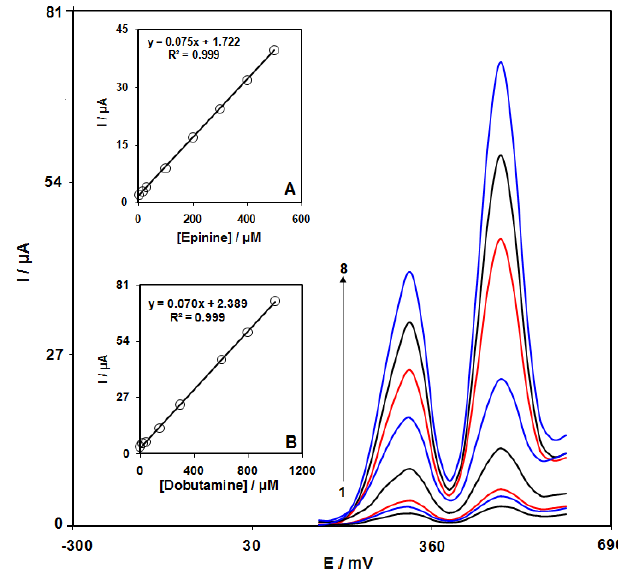
Figure 12. DPV graphs at the GO/ZIF-67/SPE in 0.1 M PBS at pH of 7.0 with various concentrations of epinine and dobutamine. Notably, numbers 1–8 correspond to 2.5 + 5.0, 15.0 + 25.0, 30.0 + 50.0, 100.0 + 150.0, 200.0 + 300.0, 300.0 + 600.0, 400.0 + 800.0, and 500.0 + 1000.0 μ M of epinine and dobutamine. ( A ): Ip plot vs. epinine concentration. ( B ). Ip plot vs. dobutamine